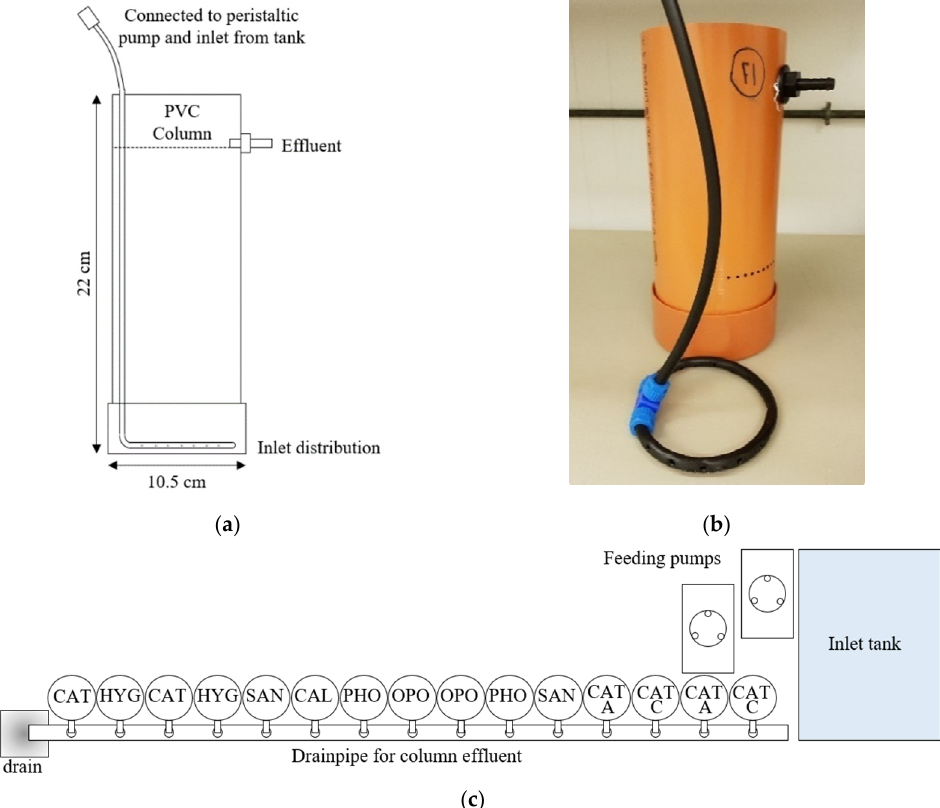
Figure 1. Column setup: ( a ) schematic overview of a single column set-up, ( b ) illustration of columns with inlet hose and inlet distribution, and ( c ) overview of the column setup.